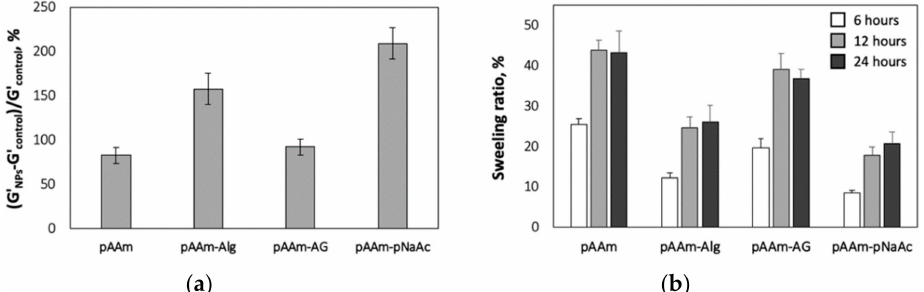
Figure 2. ( a ) Percent relative elastic moduli of pAAm, pAAM-alginate (pAAM-Alg), pAAm-agarose (pAAM-AG), and pAAm-pNaAc hydrogels, prepared using 5% pAAM, 2% second polymer (for DN hydrogel samples) and 2% 4 nm SiNPs. Values for relative elastic modulus were calculated by normalizing the values for the hydrogel nanocomposites to those for neat hydrogels not containing SiNPs, and ( b ) percent swelling ratios of pAAm, pAAM-alginate (pAAM-Alg), pAAm-agarose (pAAM-AG), and pAAm-pNaAc hydrogel nanocomposites, prepared using 5% pAAM, 2% second polymer (for DN hydrogel samples) and 2% 4 nm SiNPs at various time points—6 h (white bars), 12 h (light grey bars), and 24 h (dark grey bars). The values for swelling ratio were calculated by normalizing the values obtained for hydrogel samples at various time points to those obtained at time = 0 min. Data shown are the mean of triplicate measurements ± standard deviation and have been repeated at least three times with similar